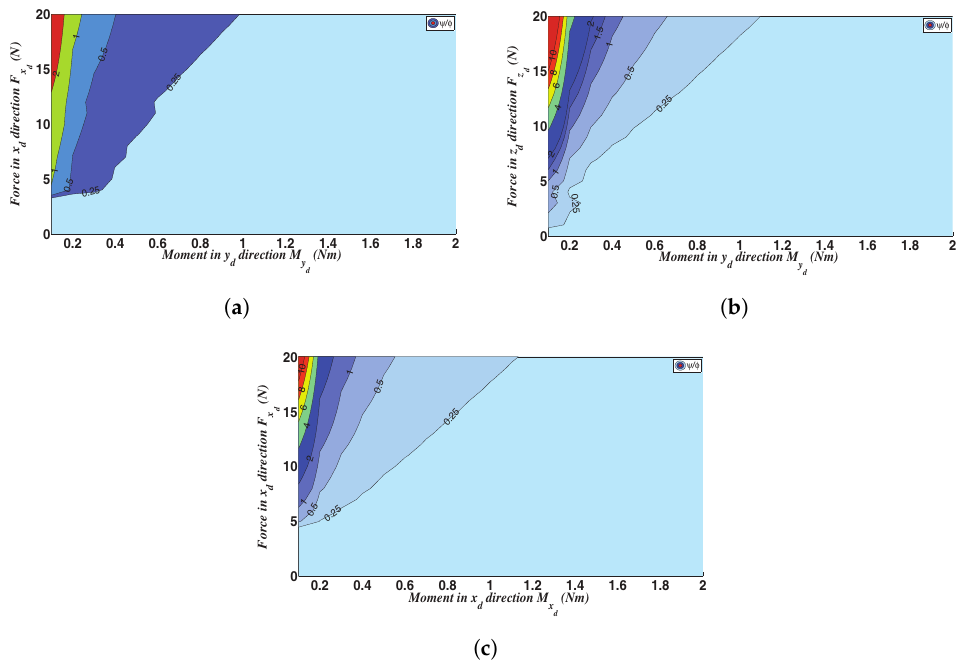
Figure 10. Contour plots of ψ / φ for three extreme loading cases: ( a ) moment M y ( b ) moment M y